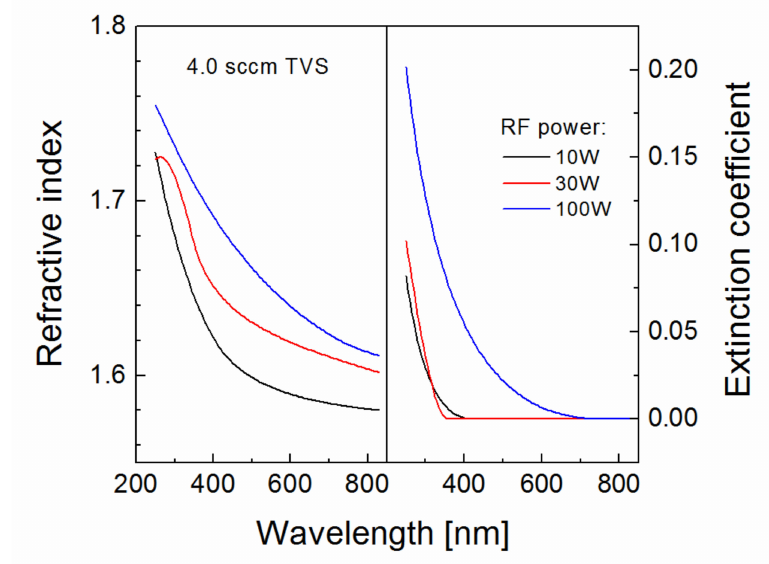
Figure 11. Dispersion curves for the refractive index and the extinction coe ffi cient corresponding to plasma nanocoatings deposited at di ff erent RF powers from pure TVS